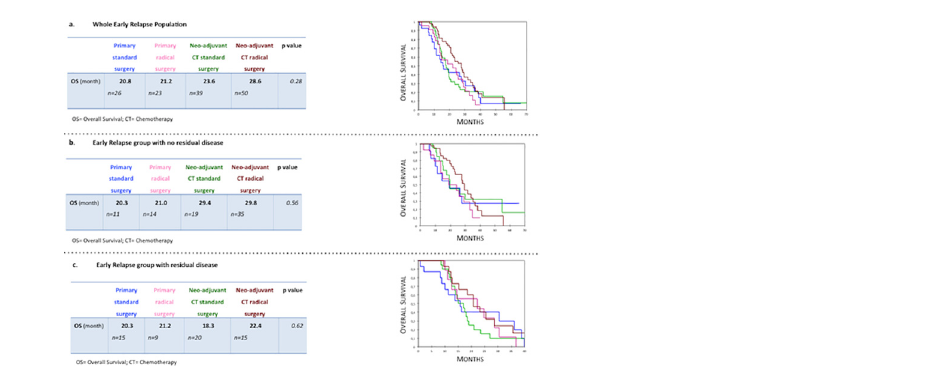
Fig 2. Comparative outcomes according to treatment patterns in (a) whole Early Relapse population, (b) patients with complete and (c) incomplete cytoreductive surgery (Kaplan Meier analysis).